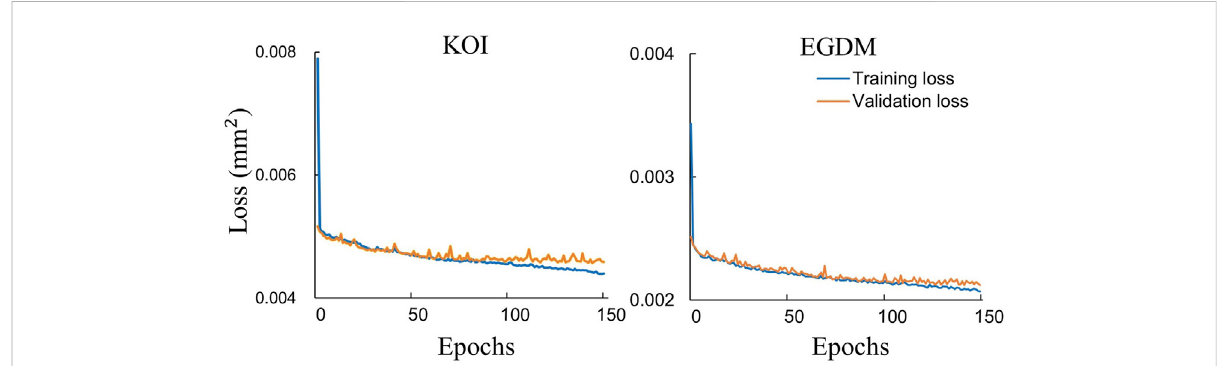
FIGURE 4 Training progress of the LSTM-RN models at stations KOI and EGDM.